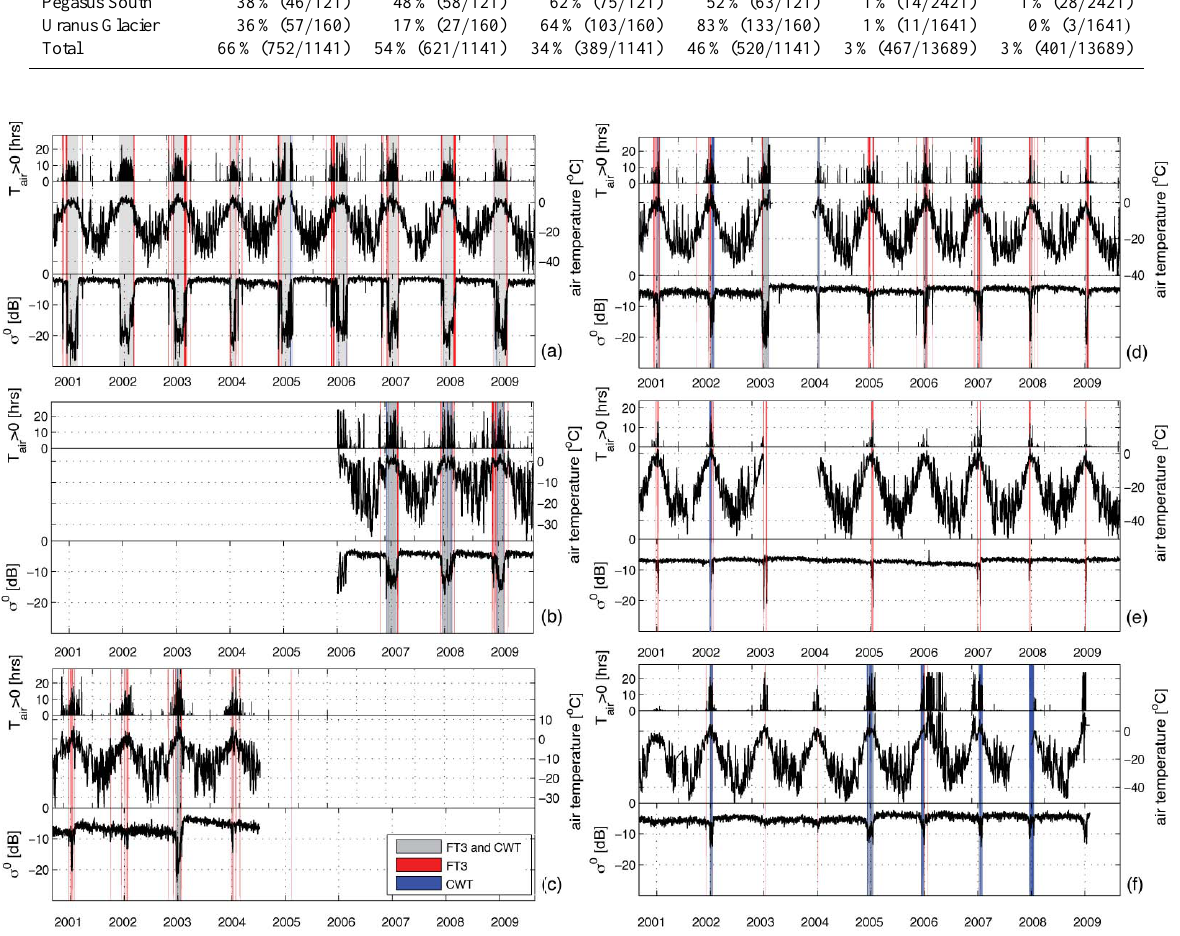
Fig. 2. AWS temperature records for (a) Larsen Ice Shelf, (b) , Fossil Bluff, (c) , Uranus Glacier, (d) Butler Island, (e) Limbert and (f) Pegasus South for 2000 to 2009 plotted with the corresponding QuikSCAT backscattering values. Times where the FT3 or CWT approaches estimate melting are shaded red and blue, respectively, while times where both methods agree are shaded